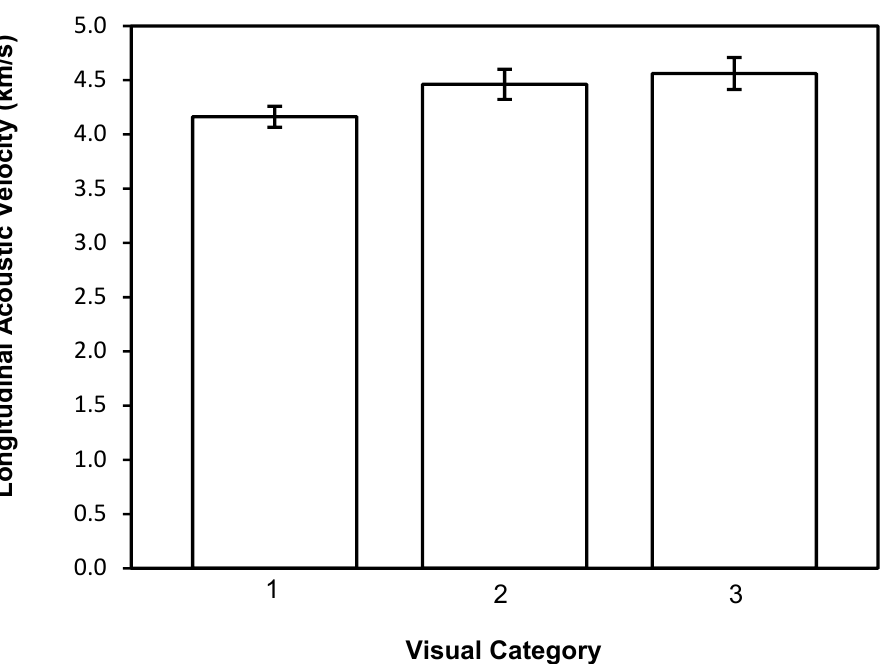
Figure 5. Mean longitudinal acoustic velocity (km/s) by visual category. Acoustic velocity was measured with the Hitman ST300. Error bars represent the 95% confidence interval.